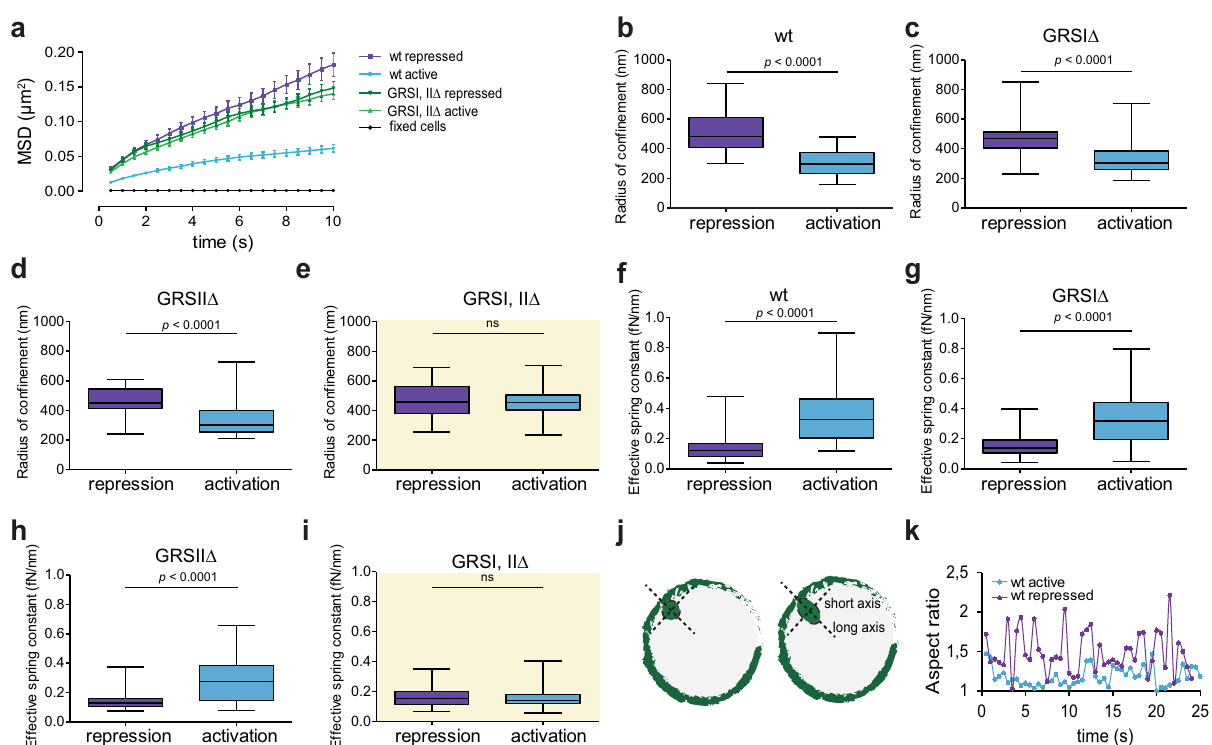
Fig. 2| INO1 dynamicsandmaterialpropertiesdependonthepresenceofboth GRSI andII.a MSDcurvesfor INO1 locusin wildtype (purpleand bluelines, n =38 and34cells,respectively)andtheGRSI,II Δ (darkandlightgreenlines, n =51and45 cells, respectively) strains under activating and repressed conditions, and for a population of fi xed cells (black line, n =8 cells). Data are presented as mean values+/ − SEM. b – d Radiusofcon fi nement(R c )signi fi cantlydecreasesin wildtype , GRSI Δ ,andGRSII Δ cellsfromrepressed(purple)toactivated(blue)conditions. e R c forGRSI,II Δ mutantcellsunderrepressing(purple)andactivating(blue)conditions show no signi fi cant differences. f – h Spring constant (k s ) for wild type , GRSI Δ , and GRSII Δ cells increases signi fi cantly from repressing (purple) to activating (blue) conditions. i k s for GRSI, II Δ mutant shows no signi fi cant difference between